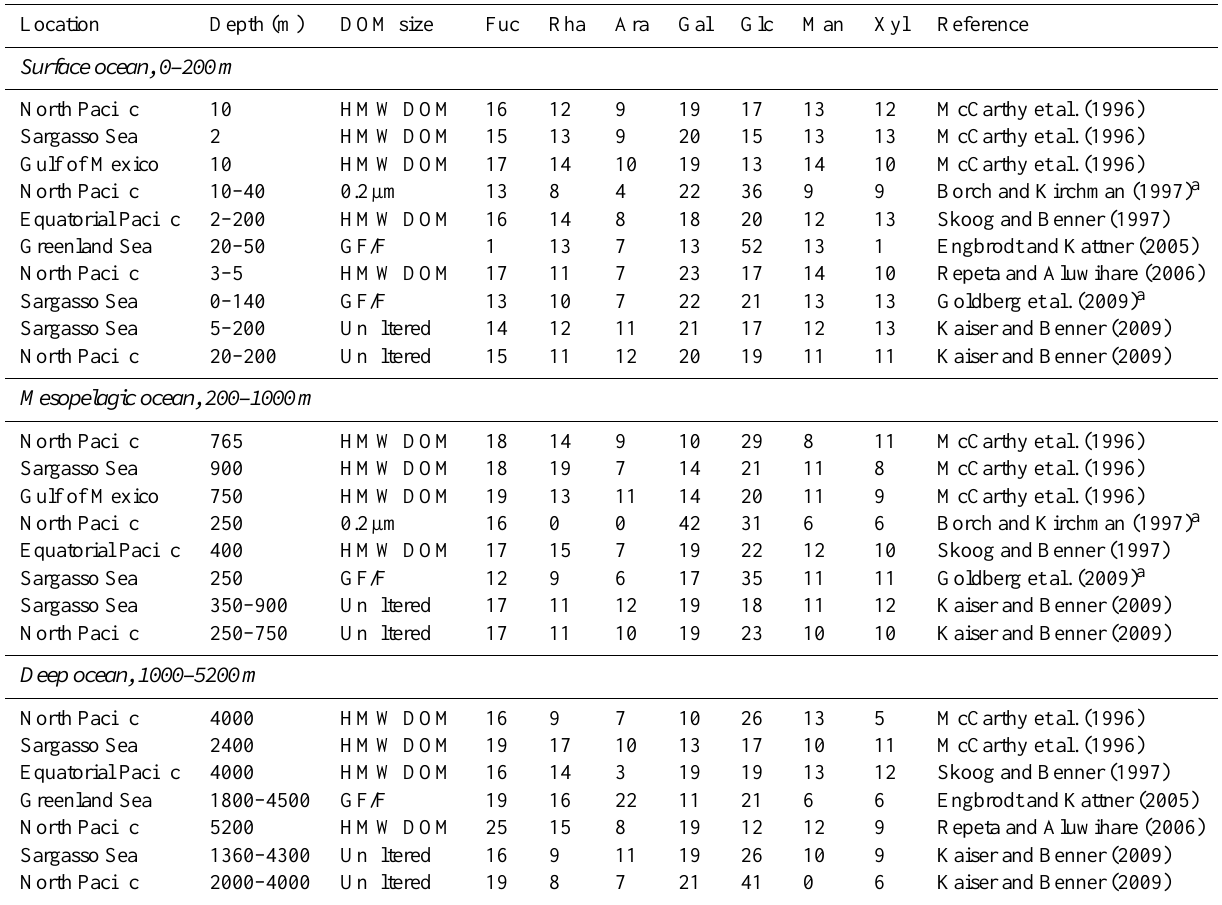
Table 3. Molecular composition (mol%) of neutral sugars found in the oceans’ surface, mesopelagic and deep layers. HMW DOM: 1nm to 0.2µm; GF/F DOM: ∼